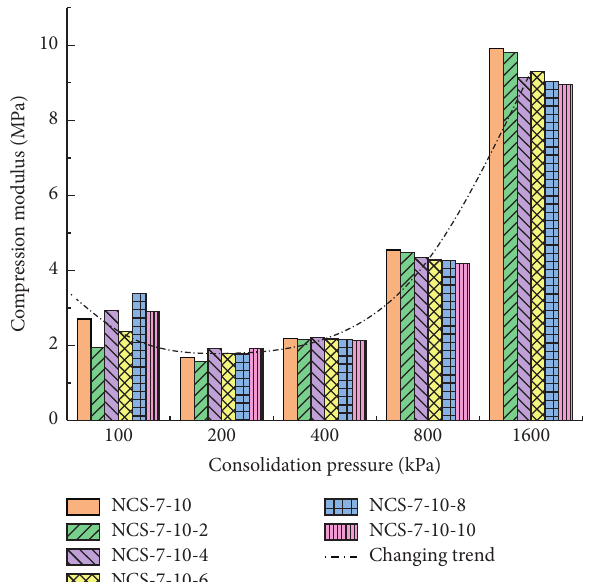
Figure 15: Es of NCS-7 with different consolidation